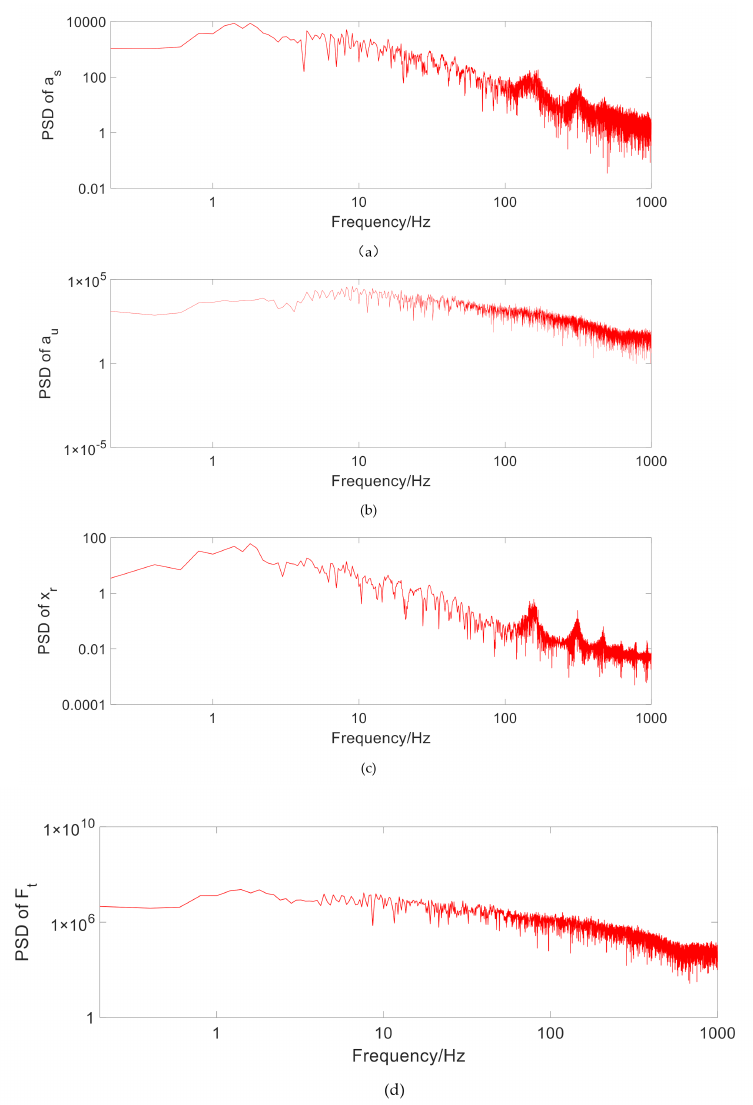
Figure 6. Power spectral density (PSD) under random road excitation. ( a ) PSD of the sprung mass acceleration, ( b ) PSD of the unsprung mass acceleration, ( c ) PSD of the suspension dynamic stroke, ( d ) PSD of the tire dynamic